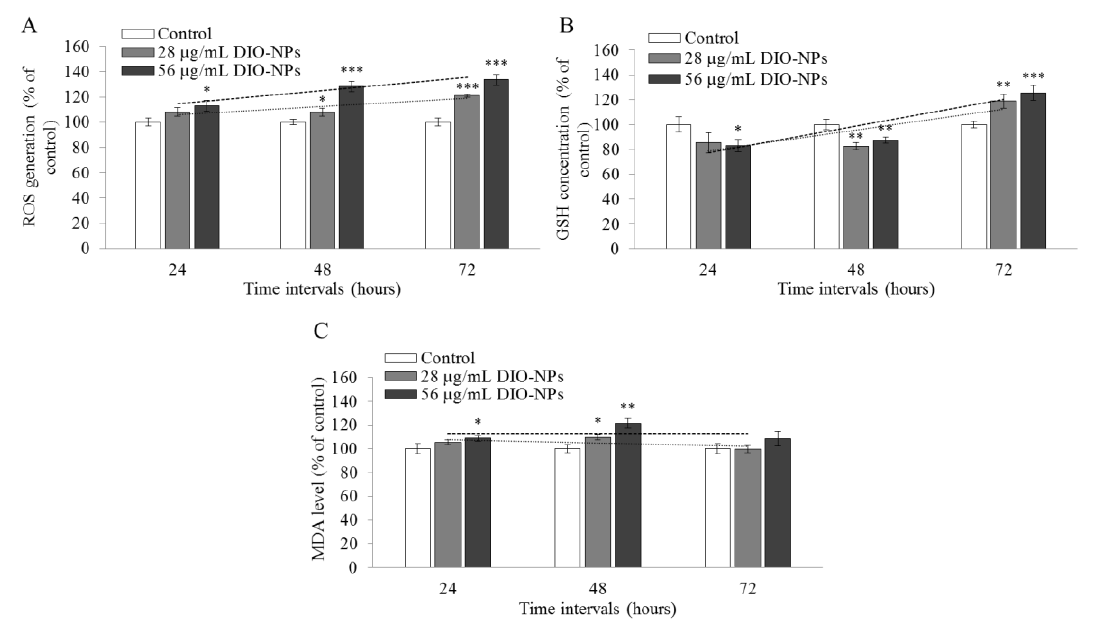
Figure 9. Effects of 28 and 56 µg/mL DIO-NPs exposure on ROS production ( A ), GSH content ( B ) and MDA level ( C ) in Jurkat cells. Values were calculated as percentage of treated cells compared to the control and expressed as means ± SD ( n = 3/experimental group). * p < 0.05 vs. control; ** p < 0.01 vs. control; *** p < 0.001 vs. control.